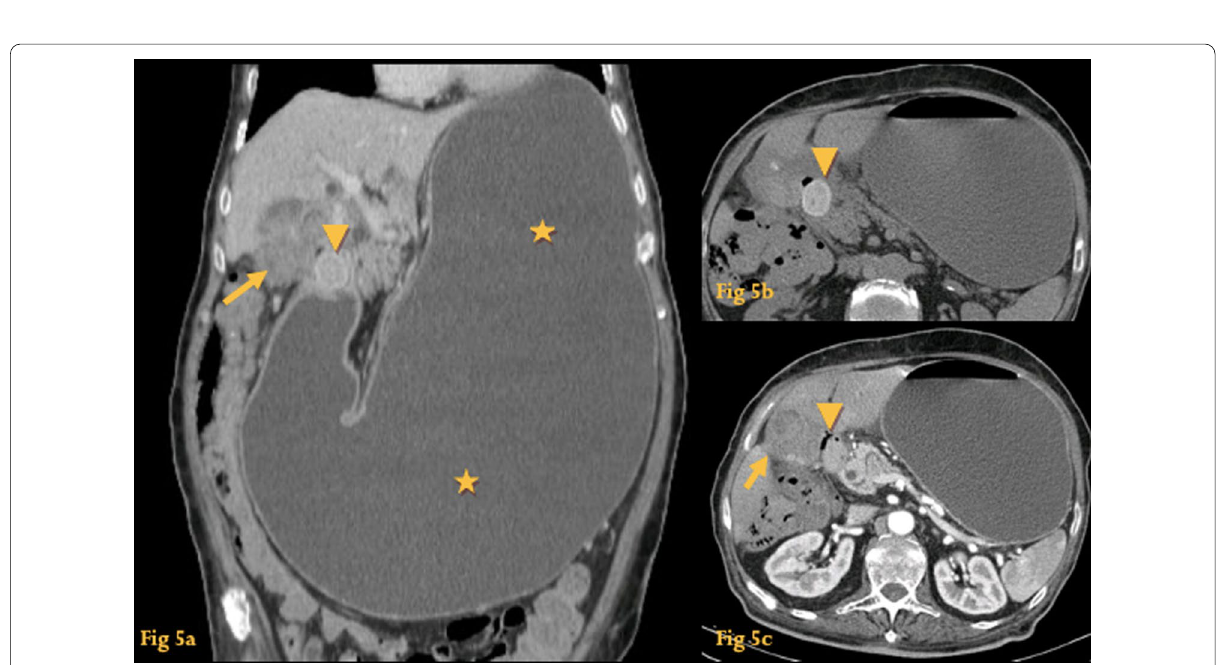
Fig. 5 Bouveret syndrome. CT coronal reformation ( a ) shows marked gastric dilatation (asterisks) caused by a round lesion at the duodenal bulb (arrowhead); there is also densification and indefinition of the contour of the gallbladder (arrow). Unenhanced CT ( b ) shows the lesion is spontaneously hyperdense‑endoluminal gallstone at the duodenal bulb (arrowhead). A small fistulous tract filled with air ( c ) (arrowhead) is seen between the duodenal bulb and the expected location of the gallbladder, which had ruptured and formed a phlegmon